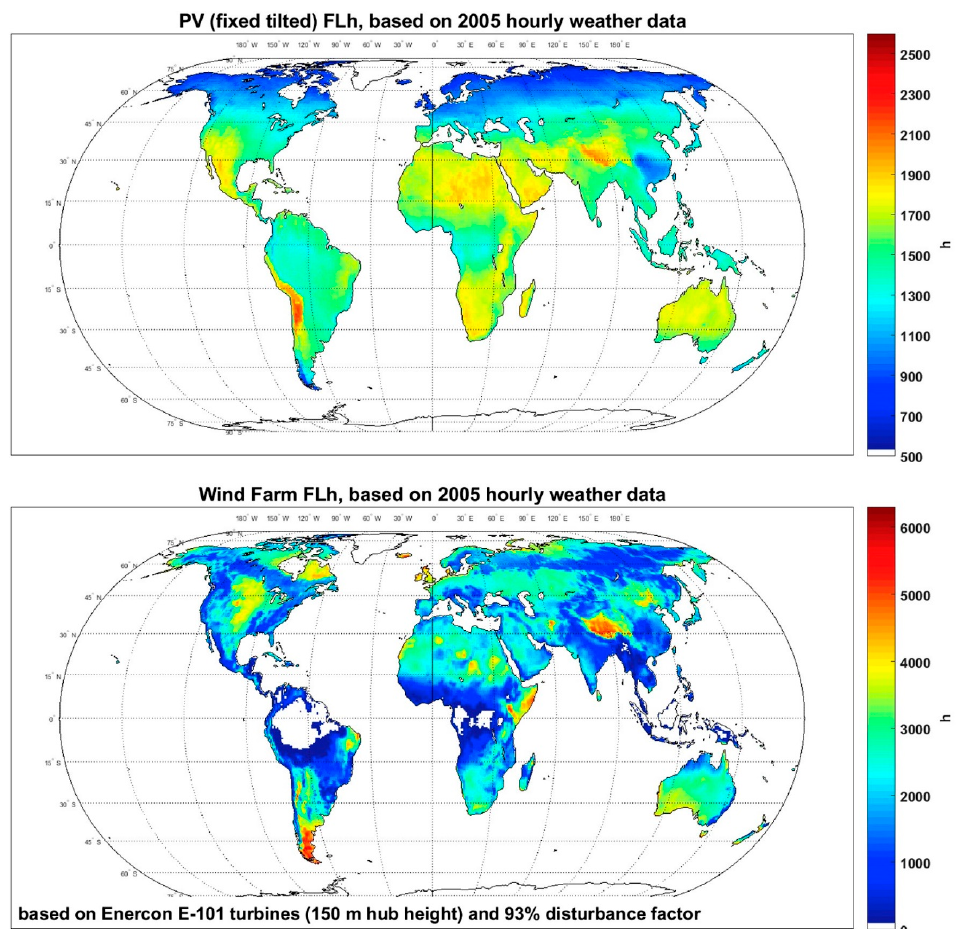
Figure 9. Heatmap describing the global PV and wind power full load hours [30].